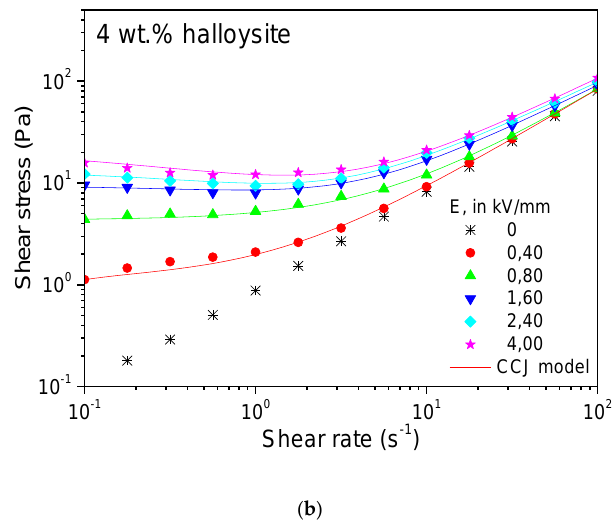
Figure 6. Steady state flow curves at 25 °C for 4 wt.% dispersions of ( a ) Cloisite 15A and ( b ) halloysite nanoclay in castor oil, as a function of electric field strength. The static/dynamic yield stress values τ y , as obtained from best fit of experimental data to Equation (1) or Equation (2), as appropriate, were plotted against the imposed electric field strength in Figure 7. For the nanocellulose dispersions at the concentrations of 4 and 6 wt.%, the evolution of τ y with E, in the electric field range from 0.16 to 4 kV/mm, was fitted by a power-law scaling, as expressed by Equation (3):